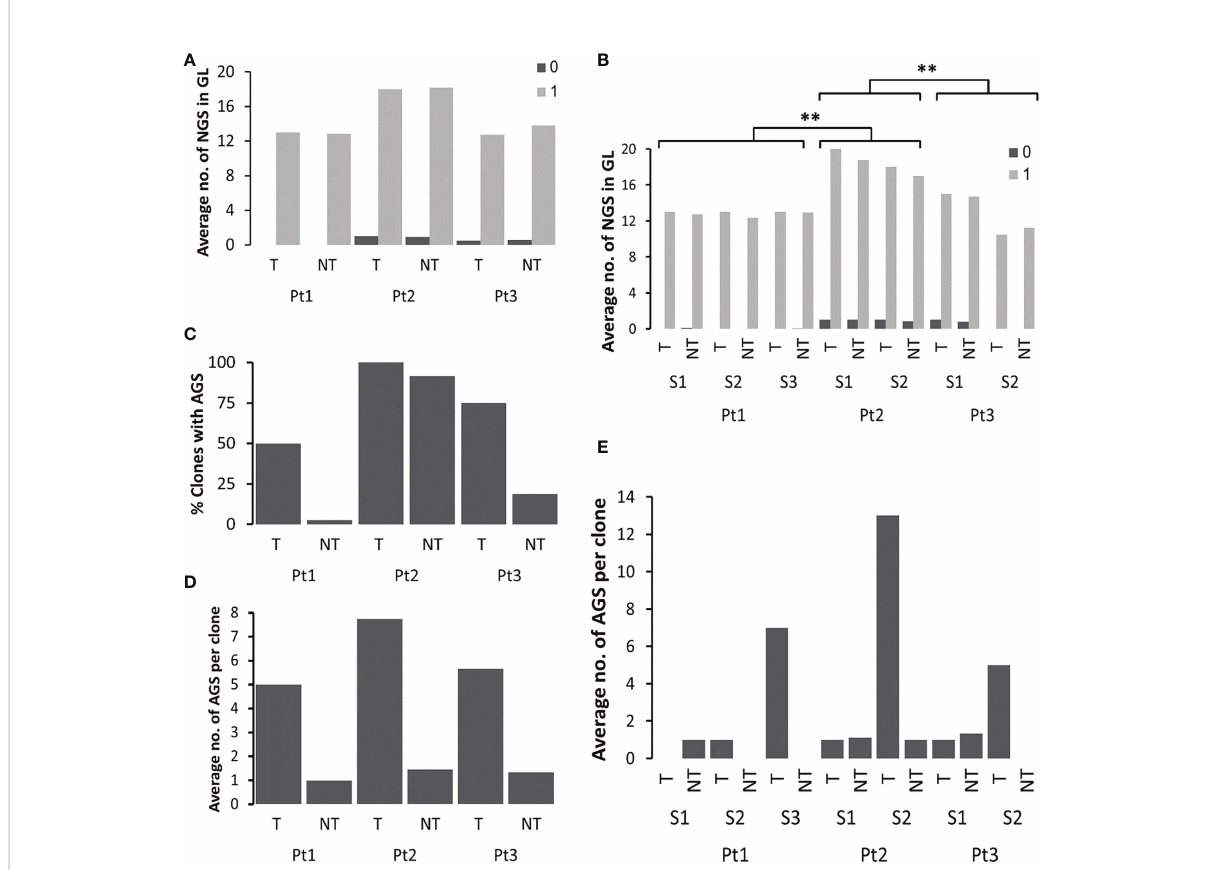
FIGURE 4 Analysis of PGS and AGS in FL samples. (A) Average numbers of existing potential PGS (0) and number of motifs that are only one mutation away from becoming an AGS (1) in clonal GL sequences, in tumor and non-tumor clones in each patient, and (B) in each sample in each patient. In case there was only one clonal GL sequence, the average number is the actual number. (C) Percentages of clones with AGS out of all clones in each patient. (D) Average numbers of AGS in tumor and non-tumor clones from each patient, and (E) from each sample in each patient. **p-value <